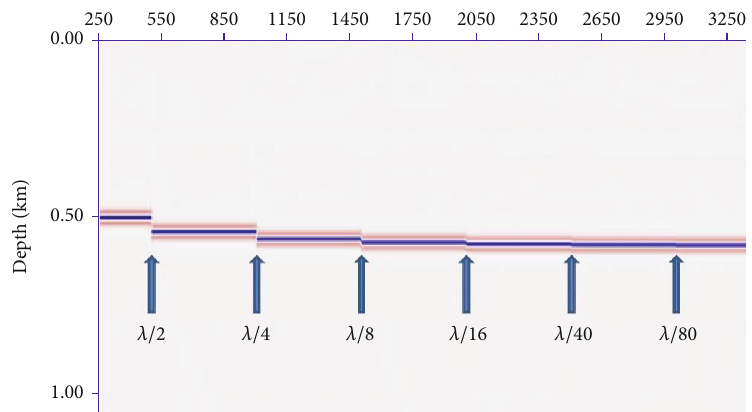
Figure 4: Forward model of the lens of di ff erent vertical